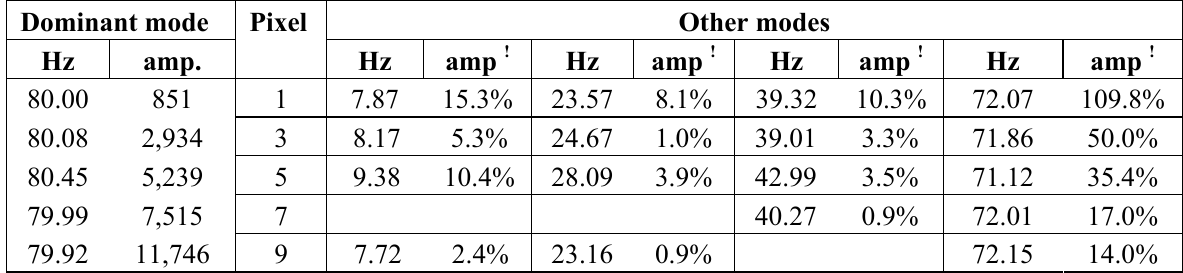
Table 5. Frequency response of the high speed camera with different black line thickness. Dominant mode Pixel Other